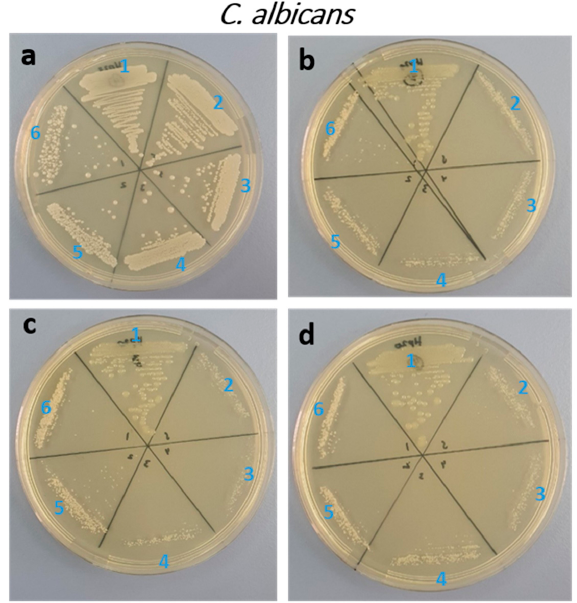
Figure 5. Agar plates showing the MIC/MFC of C. albicans upon treatment with Yb and Ce co-doped ZnO NPs (x = 0.00, x = 0.01, x = 0.03, x = 0.05). (( a ): x = 0.00, ( b ): x = 0.01, ( c ): x = 0.03, ( d ): x = 0.05), (1: untreated; 2: 0.25; 3: 0.5; 4: 1; 5: 2; 6: 4 mg/mL). The minimum MIC values were registered as 1, 0.25, 0.25, and 0.25 mg/mL for x = 0.00, x = 0.01, x = 0.03, x = 0.05, respectively. However, the MFC was higher than 4 mg/mL in all samples. The antibacterial activity was seen moderately higher against E. coli . The MIC was 2, 1, 1, 0.5 mg/mL for x = 0.00, 0.01, 0.03, 0.05, respectively. However, the MBC of 4 mg/mL was recorded with all the ratios (Table 2) and (Figure 6). Table 2. MIC/MFC/MBC of C. albicans and E. coli upon treatment with Yb and Ce co-doped ZnO NPs (x = 0.00, x = 0.01, x = 0.03, and x = 0.05).